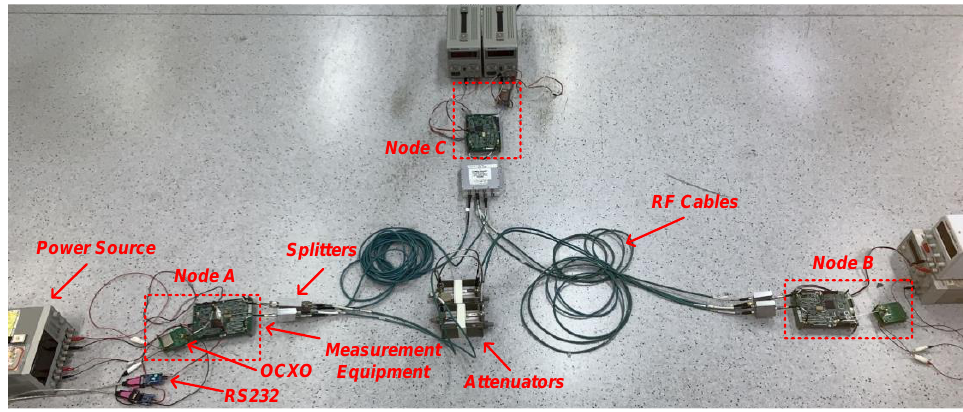
Figure 17. Experimental platform.